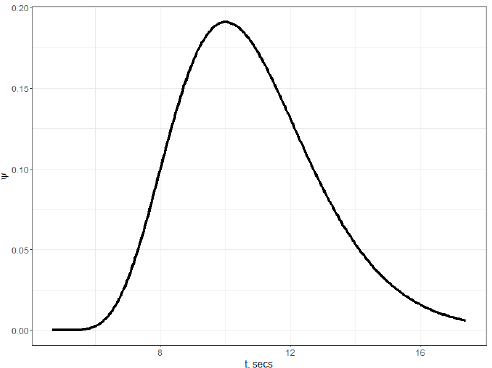
Figure 2. Estimated density of distributed delay f ( s ) for model (11).